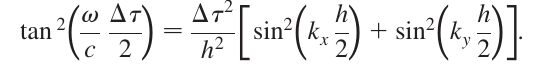
ffiffiffiffiffiffiffiffiffiffiffiffiffiffiffiffiffiffiffi